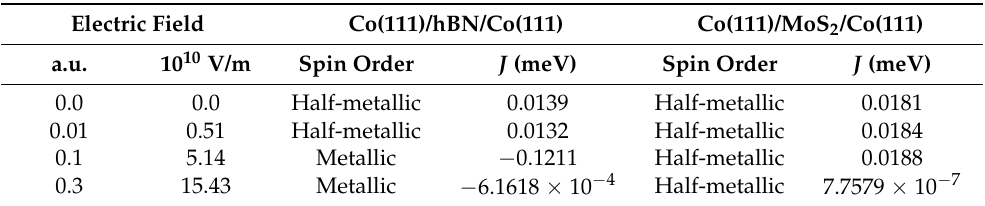
Table 2. Sensitivity of the spin order and magnetic exchange coupling to the tunnel barrier material and the applied electric